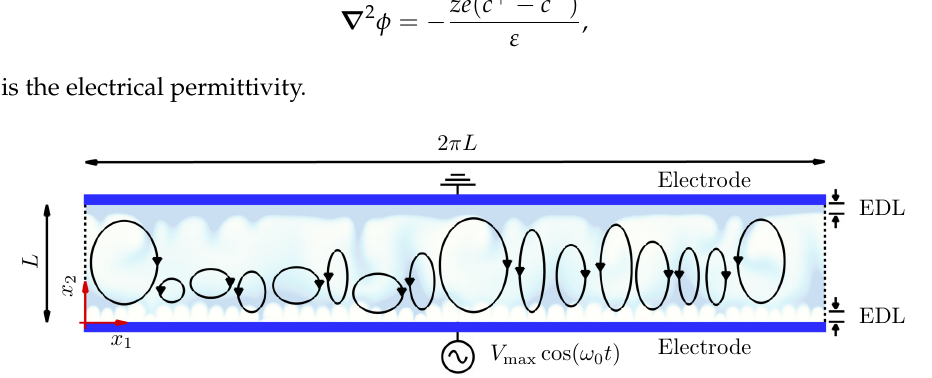
Figure 1. Computational domain. Also shown are schematics of large-scale vorticies and electric double layers (EDLs) (not to scale) near electrodes at x 2 = 0 and L (grounded). The domain is periodic in the x 1